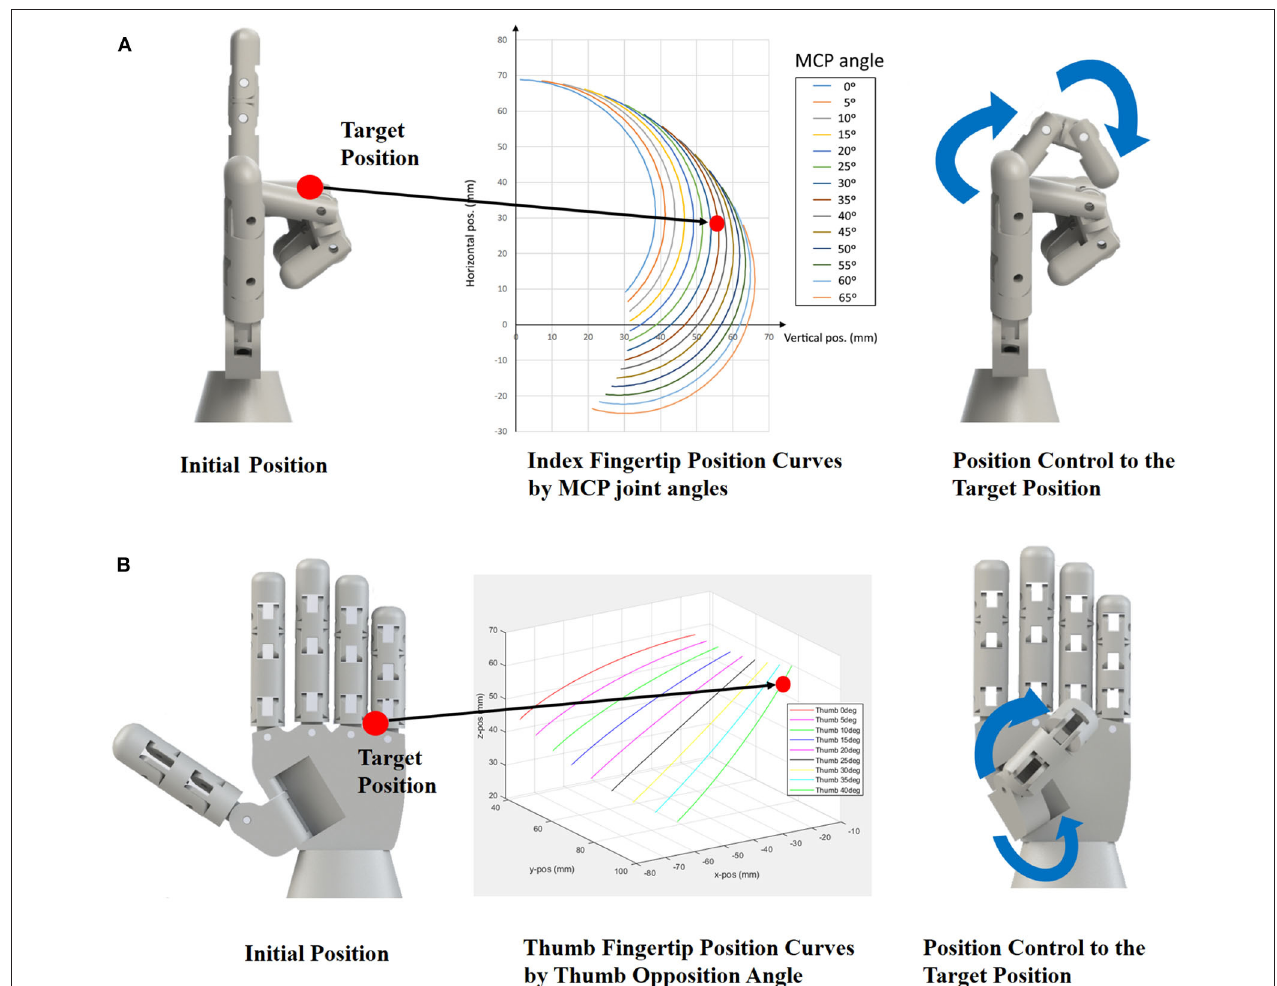
FIGURE 6 | Finger posture mapping based on the Cartesian space mapping. Given the target position of the fingertip (red circle), an end-effector position curve closest to the position is selected. (A) Control of the index finger posture. (B) Control of the thumb